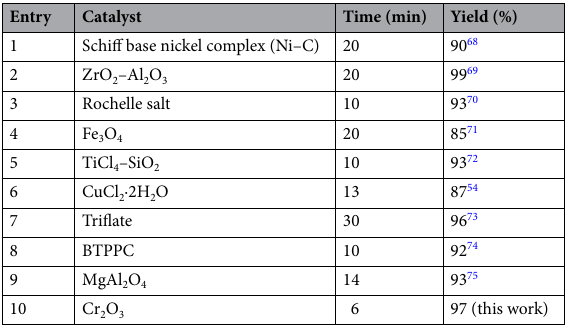
Table 6. Comparison of various heterogeneous catalysts in the formation of compound 4a